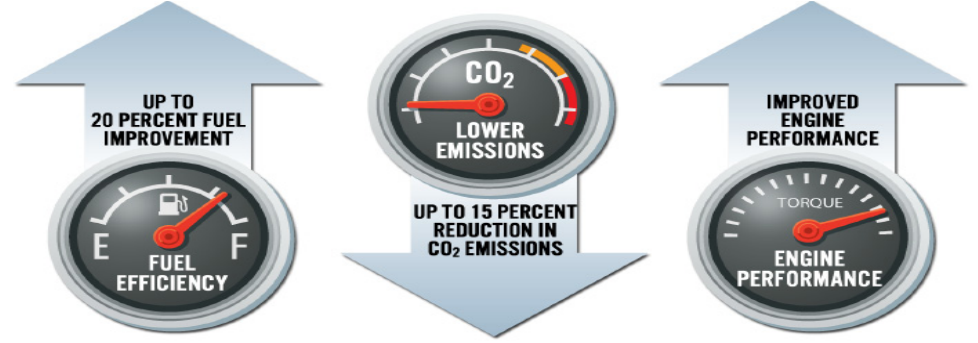
Figure 5. The performance of turbocharged EcoBoost engine. Source [34].